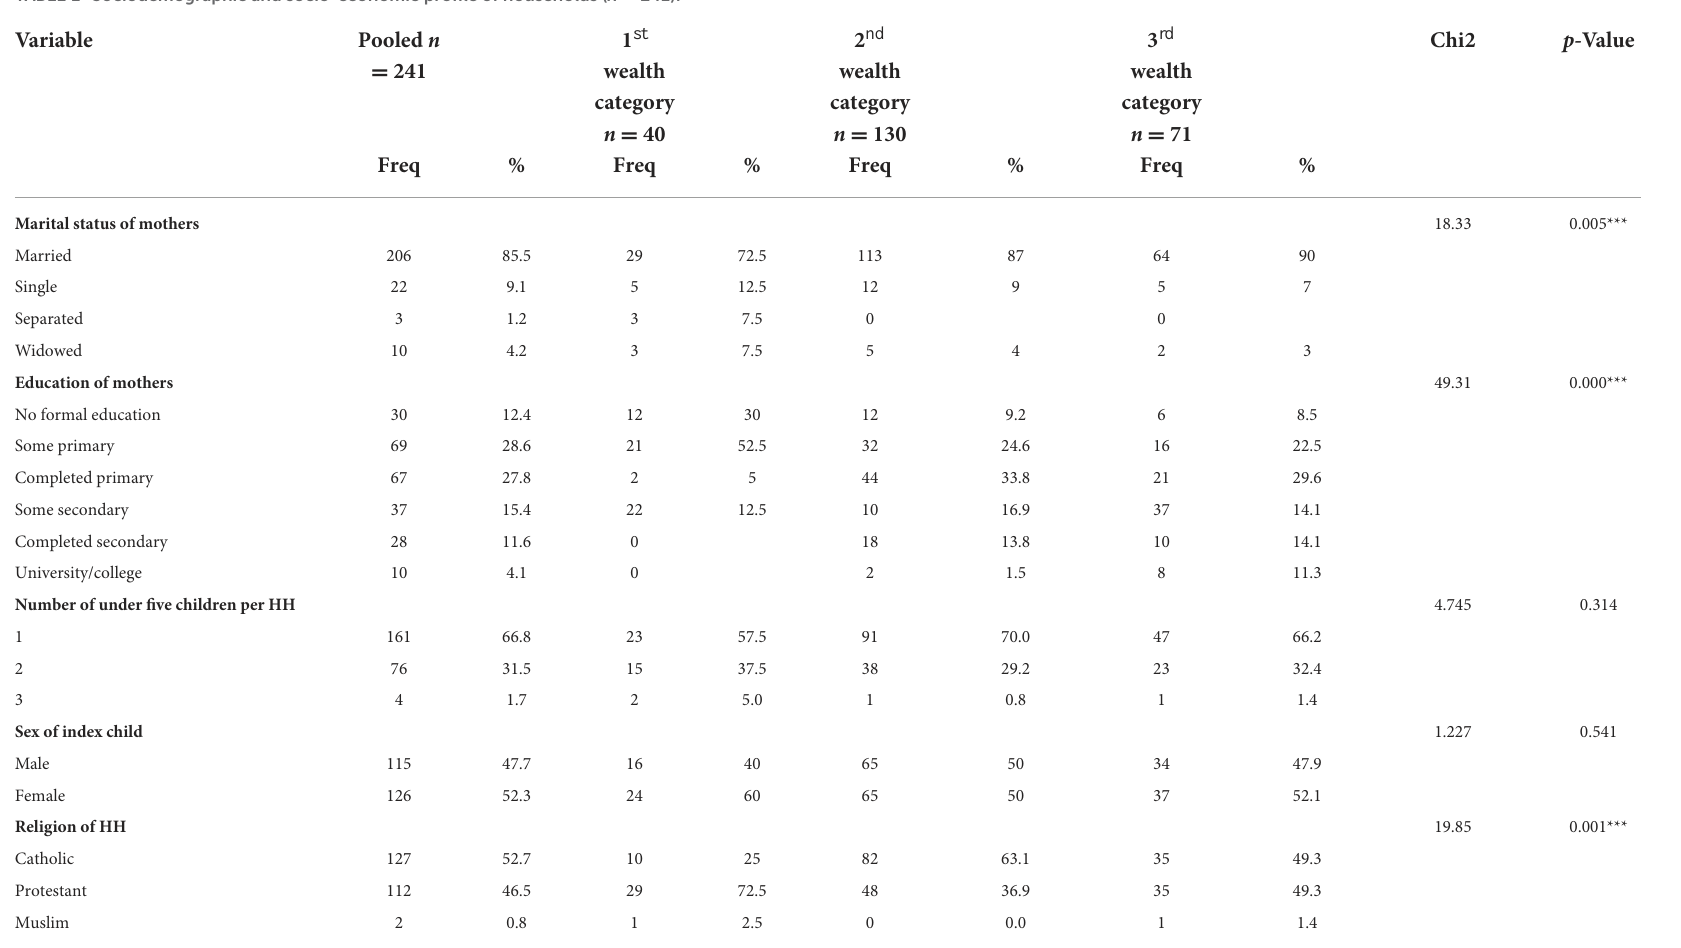
TABLE 1 Sociodemographic and socio-economic profile of households ( n = 241). Variable Pooled n